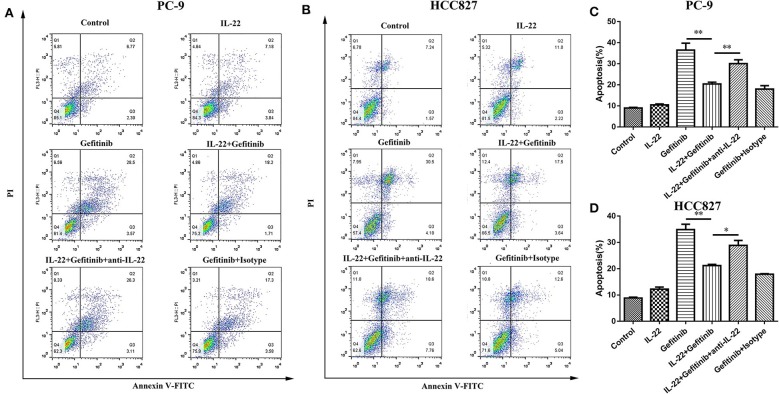
IL-22 protected PC-9 and HCC827 cells from apoptotic death after gefitinib treatment. (A,B) Analysis of apoptosis following 6 independent treatments. PC-9 (A) and HCC827 (B) cells were treated in the presence or absence of gefitinib (IC50) for 48 h prior to exposure to 50 ng/ml IL-22, 104 ng/mL IL-22 neutralizing antibody and mouse IgG1 Isotype control for additional 24 h and subjected into Annexin V based-flow cytometric analysis according to the manufacturer's instruction. (C,D) The % of apoptotic cell is indicated in right. *P < 0.05, **P < 0.01. anti-IL-22, IL-22 neutralizing antibody; Isotype, mouse IgG1 Isotype control.